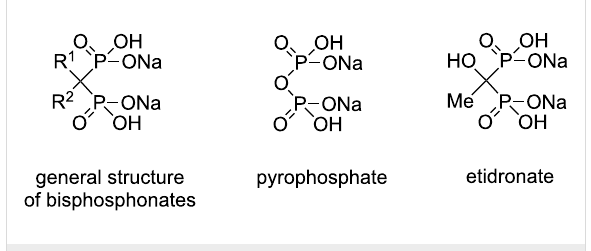
Figure 1: Structure of etidronate, pyrophosphate and general struc- ture of bisphosphonates.